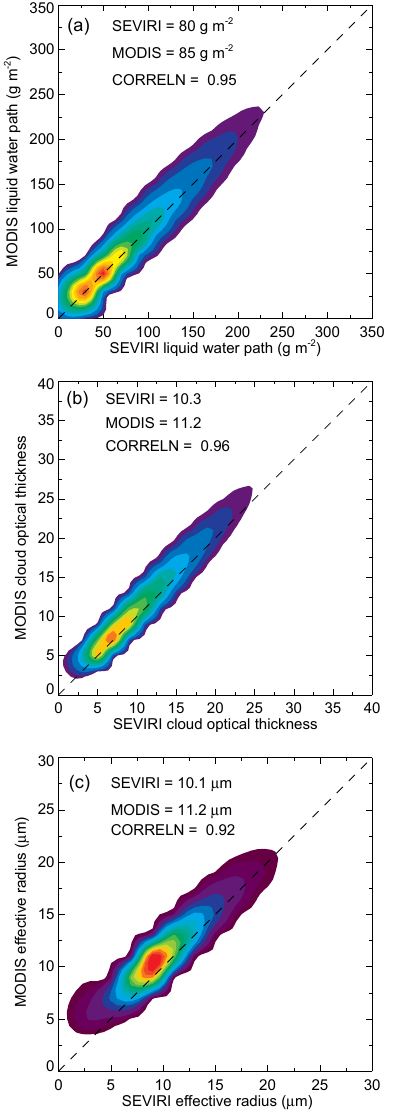
Figure 8. Scatter density plot of SEVIRI versus MODIS 1.6µm liquid water path, cloud optical thickness, and effective radius in the overcast case (LCF ≥ 95% and τ > 3) in 2 years of data. Rain-, ice-, and smoke-free conditions were applied.